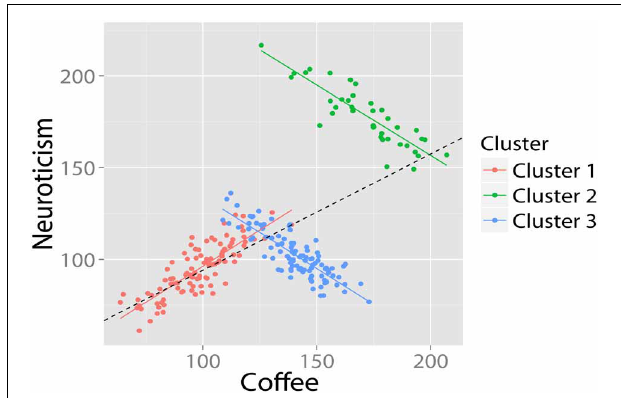
FIGURE 6 | Using cluster analysis to uncover Simpson’s Paradox. The cluster analysis (correctly) identifies that there are three subclusters, and that the relationship in two of these both deviates significantly from the group mean, and is in the opposite direction. Data in arbitrary units.